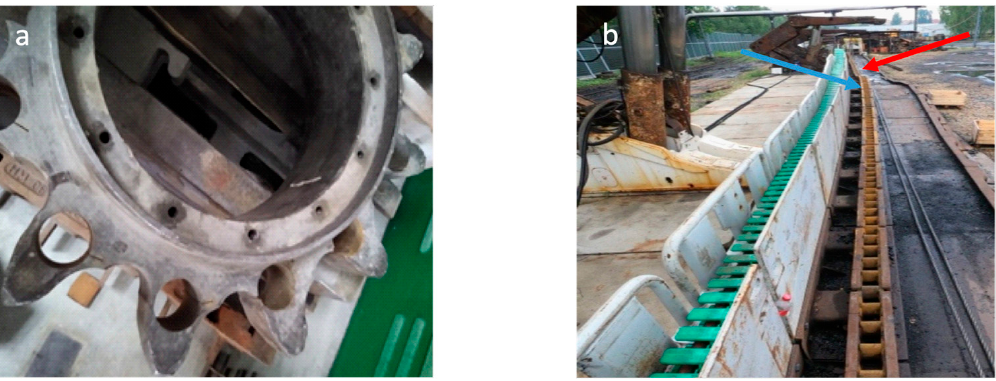
Figure 14. Elements of the longwall shearer haulage system: ( a ) drive wheel; ( b ) track.